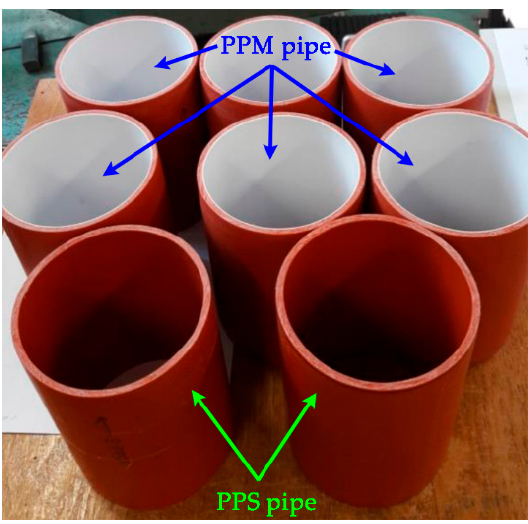
Figure 1. Pipe pieces.